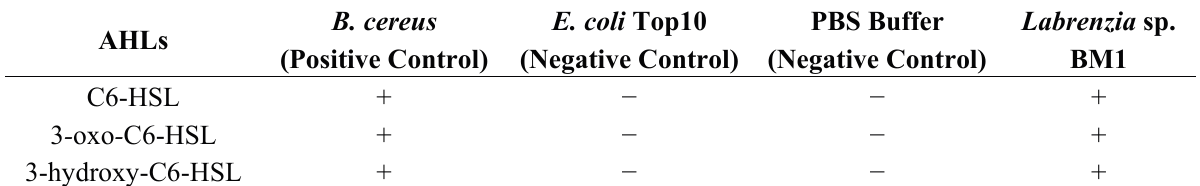
Table 1. Summary of AHLs inactivation assays detected using CV026